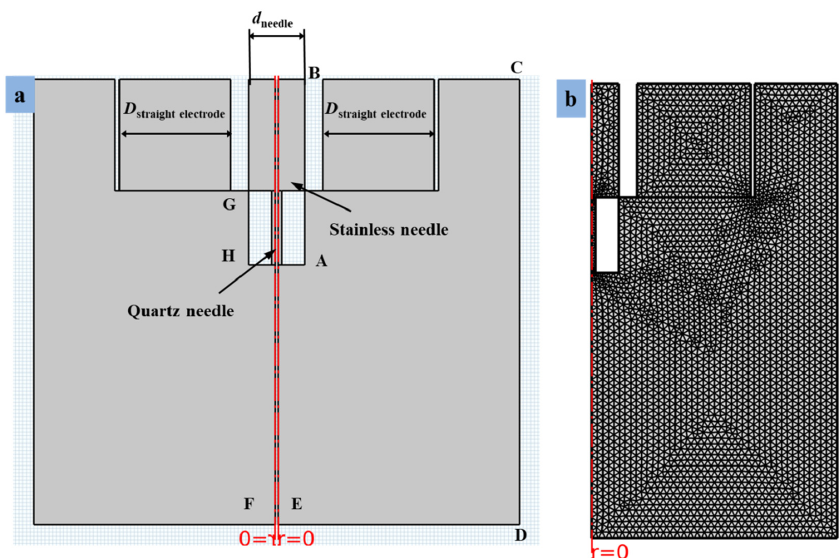
Figure 4. The simulation model for the DoD e-jet printing process. ( a ) Geometry preparations and setting of boundary conditions. ( b ) The finer meshing for the simulation process . Table 2. Simulation boundary conditions of electrostatic field and flow field .